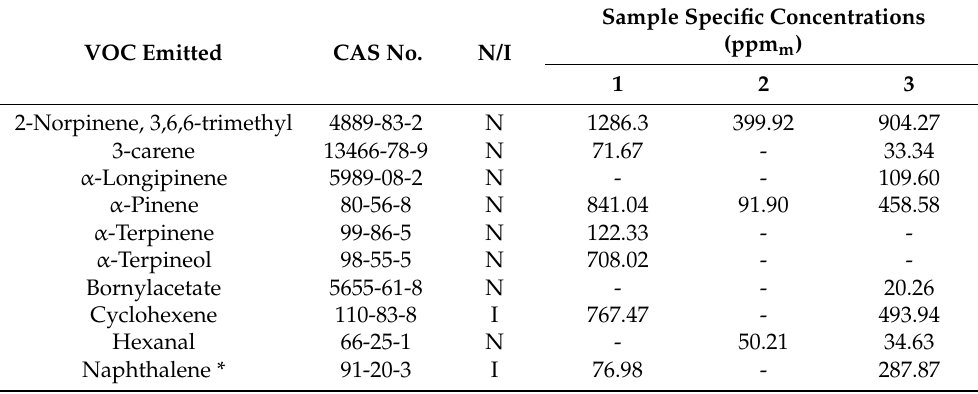
Table 2. Identified VOCs emitted from three samples of recycled wood, categorized with CAS no., origin (N = naturally occurring/I = incorporated chemical) and concentration in ppm m . * denotes the chemicals for which characterization factors